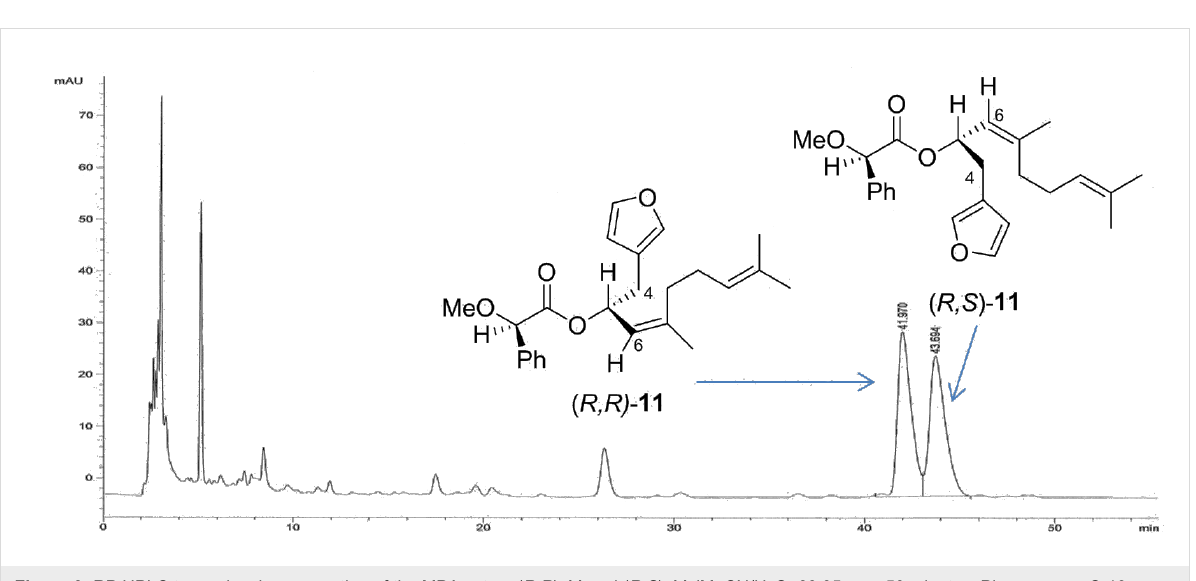
at δ H 5.13, respectively, in agreement with H-6 of the ( R,R )- isomer positioned in the shielding cone of the aryl ring of the MPA moiety [25]. The diastereotopic H-4 signals in ( R,S )- 11 at δ H 2.51 and 2.58 were shielded compared to those in ( R,R )- 11 ( δ H 2.64, 2.74). Likewise, the furan proton signals were shifted upfield in the ( R,S )-isomer compared to the ( R,R )-isomer. These data were in agreement with the configurations depicted in Figure 6. The MPA ester spectra acted as reference data for determination of the absolute configuration of the natural sample of dendrolasin-5-acetate ( 1 ). The individually-purified enantiomers of synthetic (6 Z )-5-hydroxydendrolasin were each treated with ( R )-MPA to give their respective MPA ester derivatives. The 1 H NMR spectra of the MPA ester of (+)- 7b